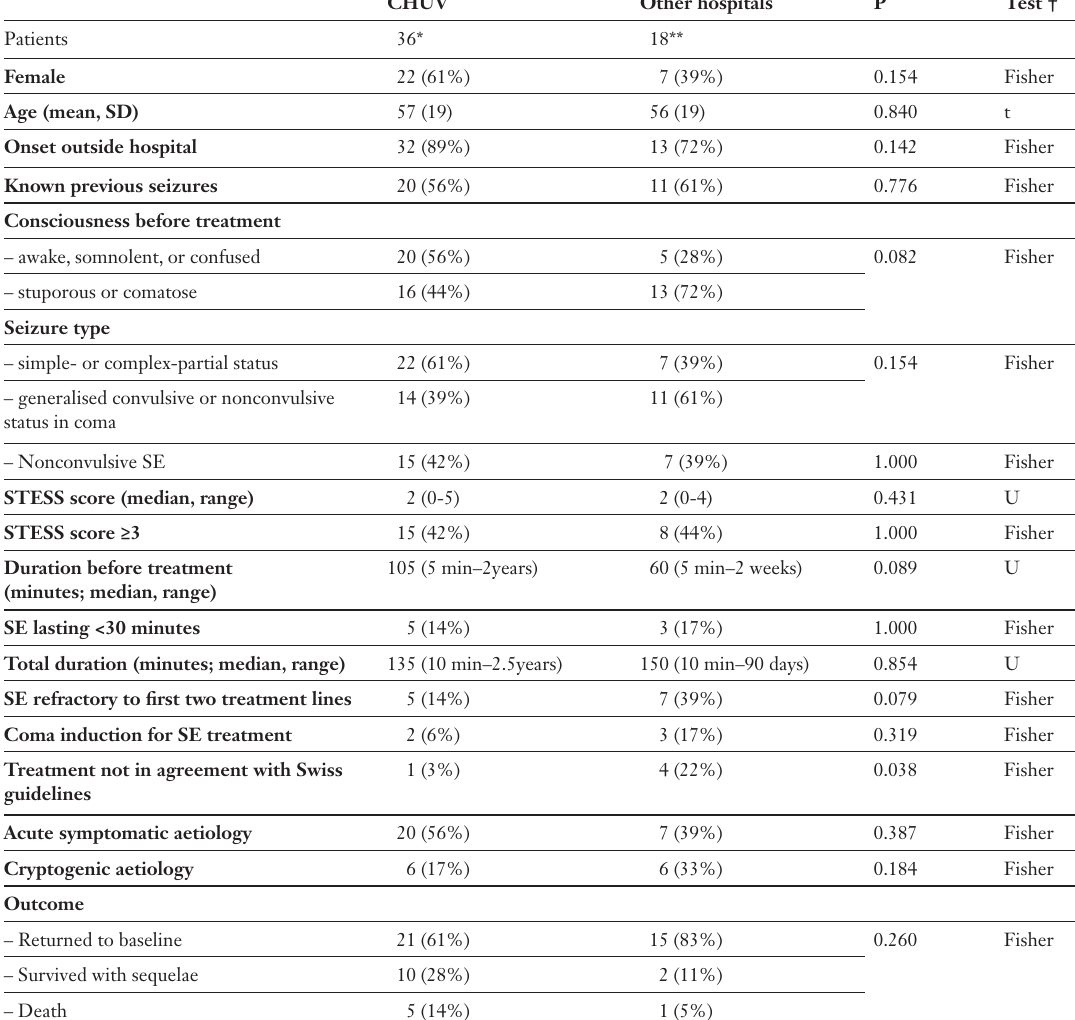
Clinical data of patients with SE treated at the CHUV and at six outside